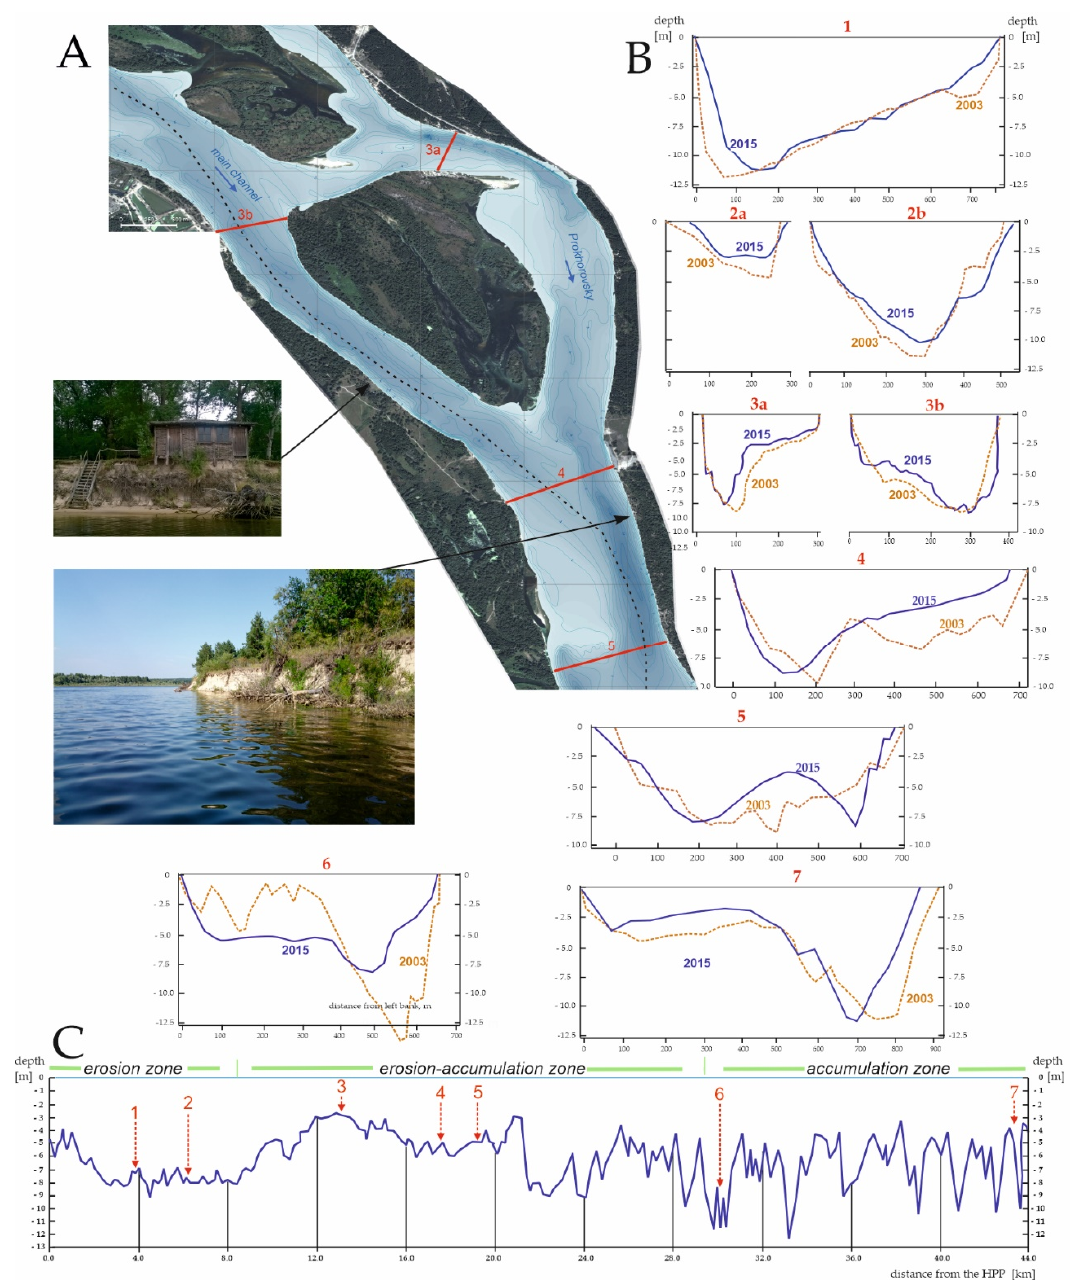
Figure 3. Section of the bathymetric map of the Dnieper River in July 2015 (main channel and lateral inter-island channel) below Kaniv HPP ( A ), selected bathymetric cross profiles in 2003 and July 2015 ( B ) and longitudinal profile of thalweg depths ( C ). Notations: cross-section location 1–7 as in Table 1.